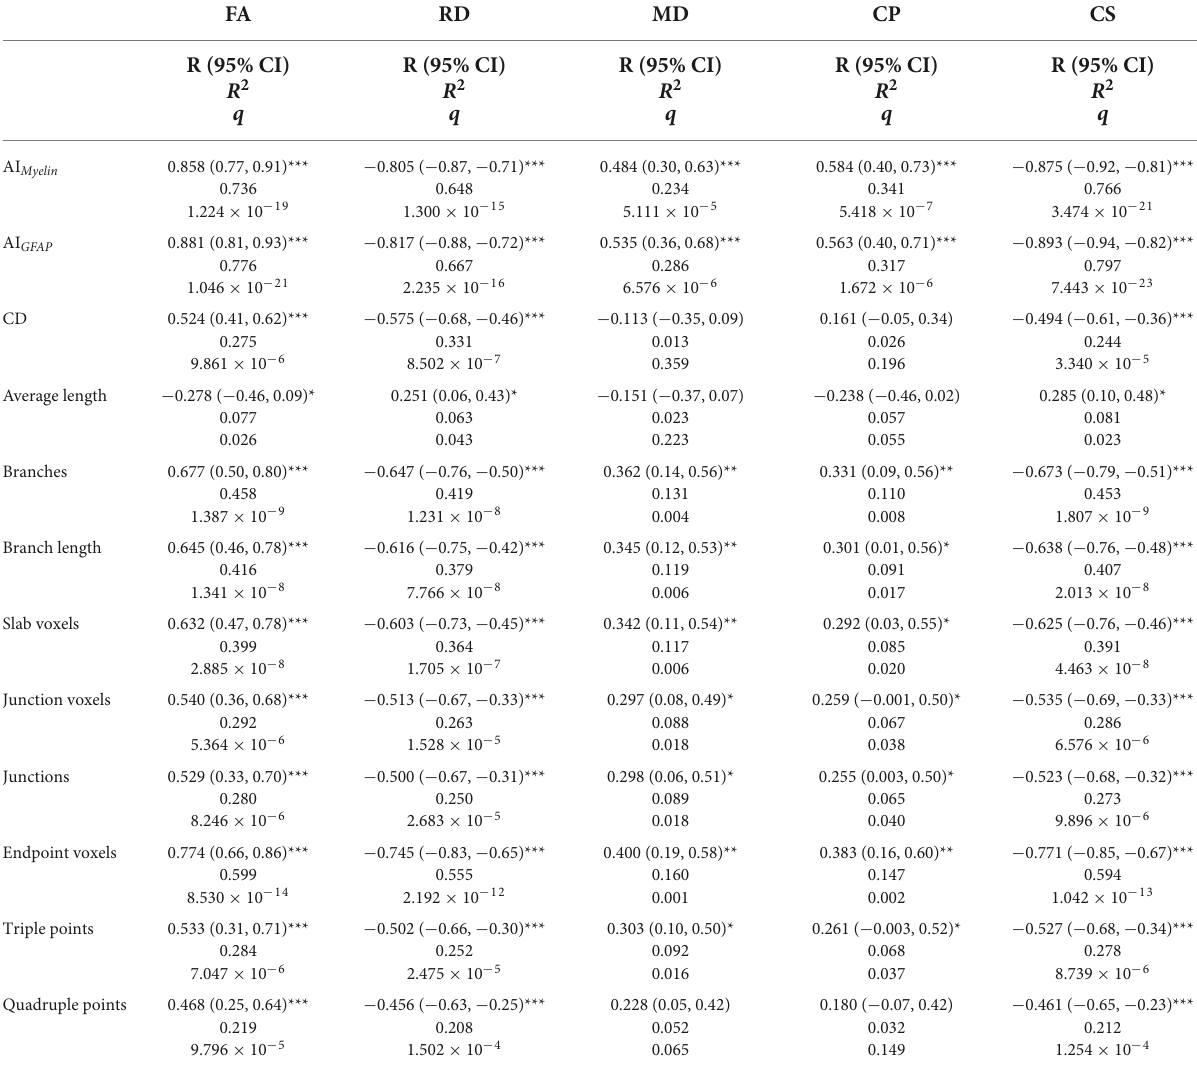
TABLE 4 Pearson’s correlations analyses between DTI and histological